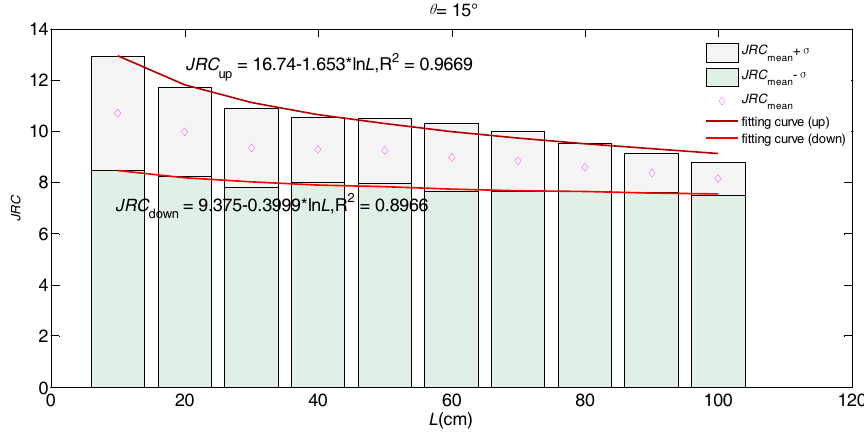
Figure 4. JRC values of different sized joint samples in the orientation of 0°. Information 2017 , 8, x FOR PEER REVIEW